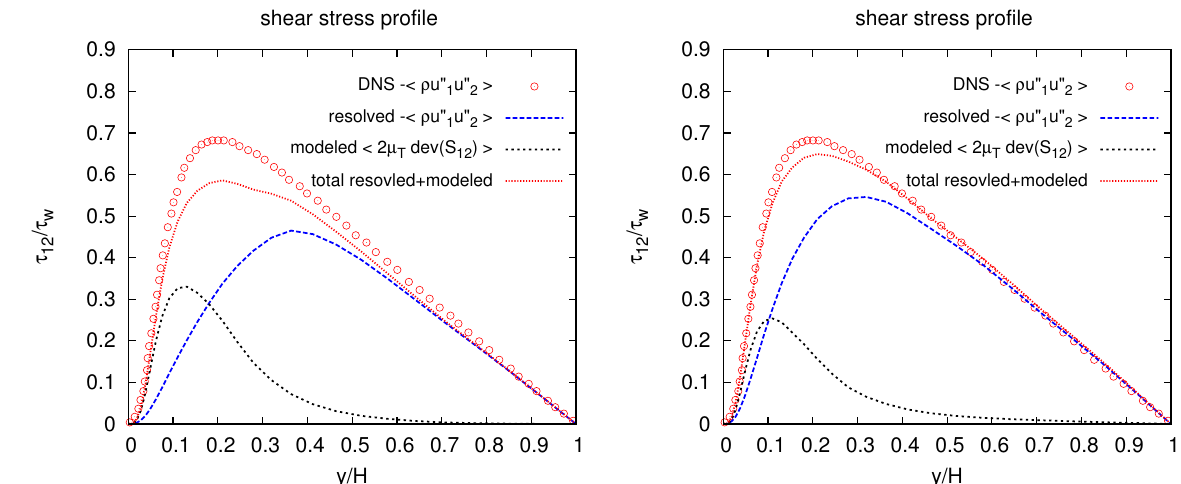
Figure 11. WA-DDES of supersonic channel flow: turbulent shear stress profiles predicted without ( left ) and with ( right ) split adaptation, compared to reference DNS